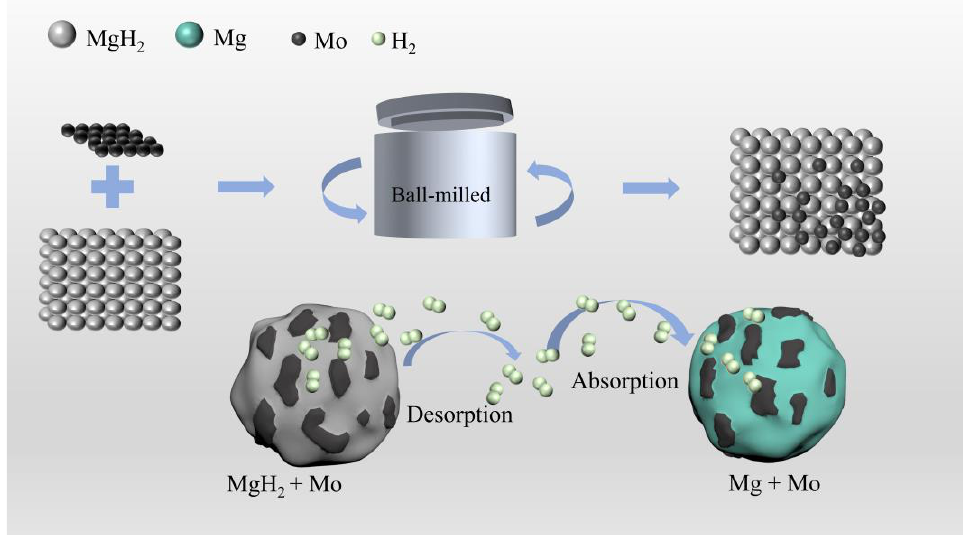
Figure 6. Schematic catalytic diagram of the MgH 2 -7wt%Mo composite.